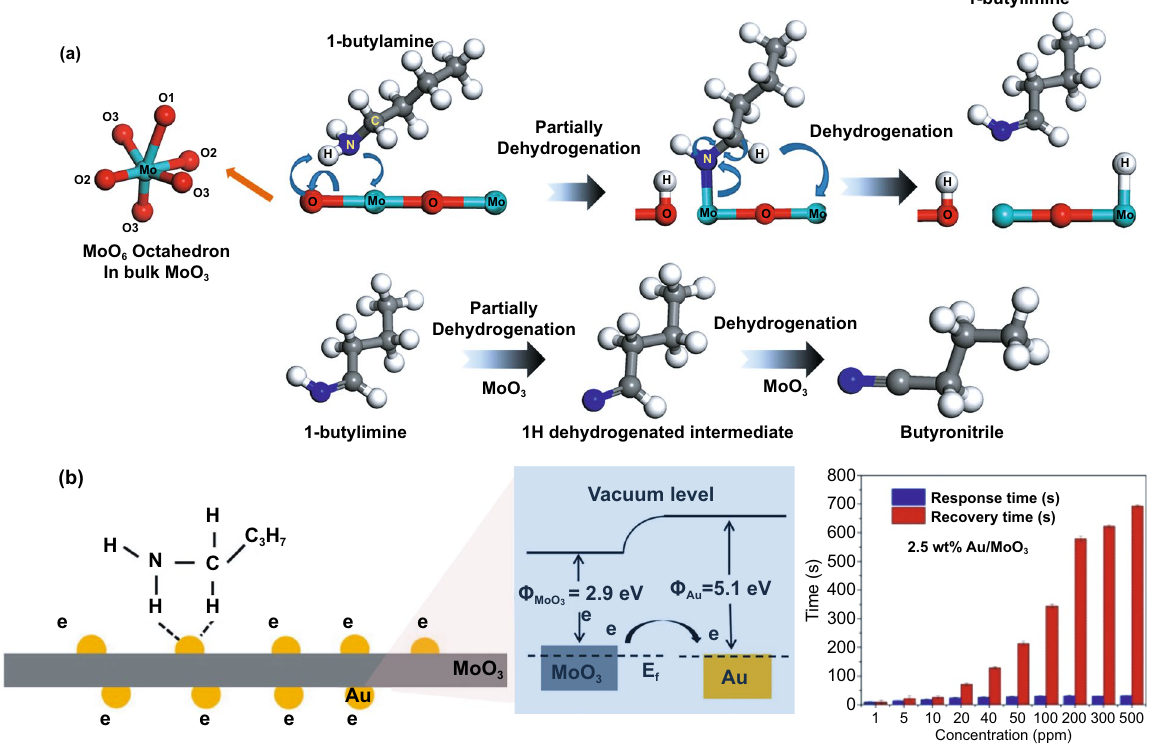
Fig. 5 a Schematic diagram of the sensing mechanism toward 1-butylamine on the MoO 3 surface. The dehydrogenation pathway and the elec- tron transfer to the Mo site are displayed. The liberated proton over Mo and the adsorption OH are assumed to adsorb as water. b Proposed mechanism of the adsorbed dehydrogenation process on Au/MoO 3 nanocomposites and its consequence to response and recovery time. Adapted with permission from Ref. [106] Copyright 2021 Elsevier